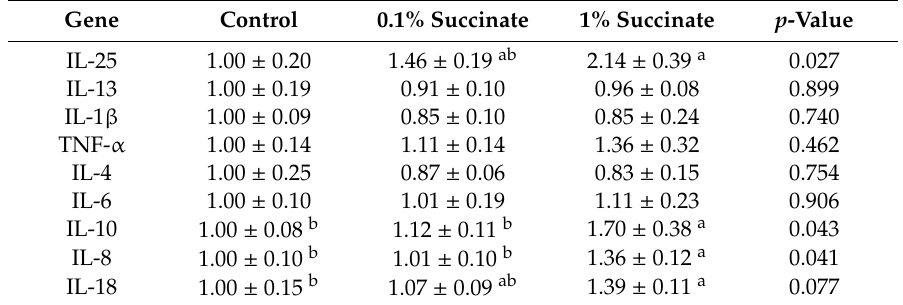
Table 5. E ff ects of diet sodium succinate supplementation on the mRNA levels of inflammatory cytokines in the jejunum of pigs.